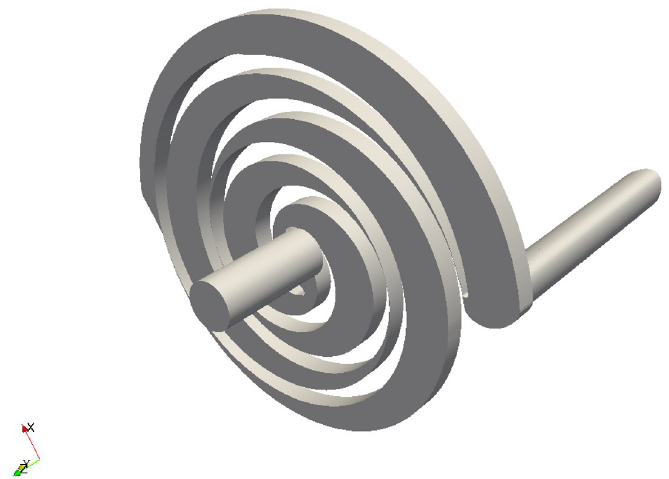
Figure 3. Fluid domain of the scroll expander comprehensive of the high pressure (central) and discharge ports.